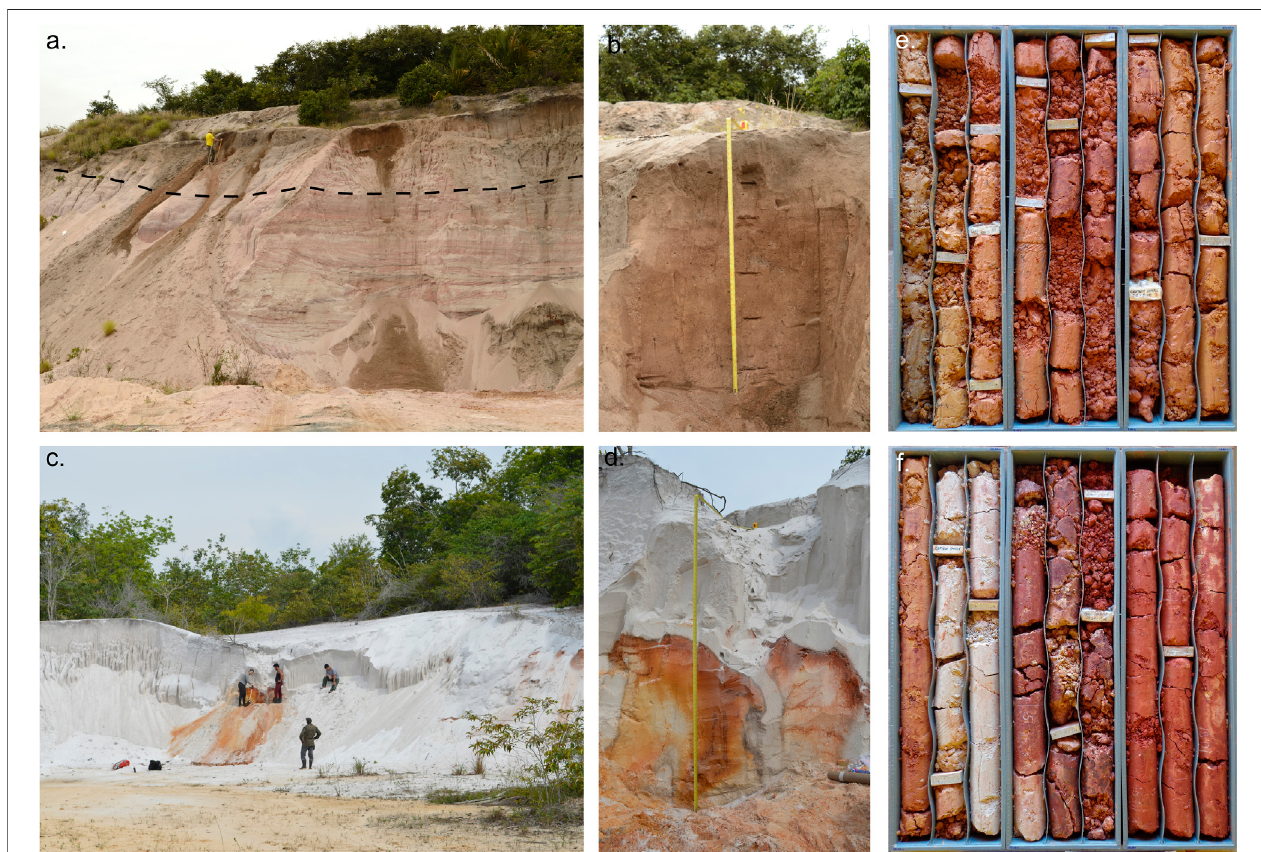
FIGURE 2 | (A) AVA01 outcrop in Eastern Amazonia with savanna sandy substrate covering late Cretaceous-Paleogene sandstones from the Alter do Chão Formation (dashed black line indicates the upper boundary of the Alter do Chão sandstones); (B) close-up image of the savanna sandy substrate in AVA01; (C) AVA22 outcrop of sandy deposits covered by white-sand vegetation ( campina ) in Central Amazonia; (D) close up image of the sandy substrate of white-sand vegetation; (E) Autazesdrillcoreweatheredsandstonesandsiltstonesfrom0to10.42 mdepth(fromlefttoright), (F) Autazesdrillcoreweatheredsandstonesandsiltstonesfrom 10.42 to 18.85 m depth (from left to right).